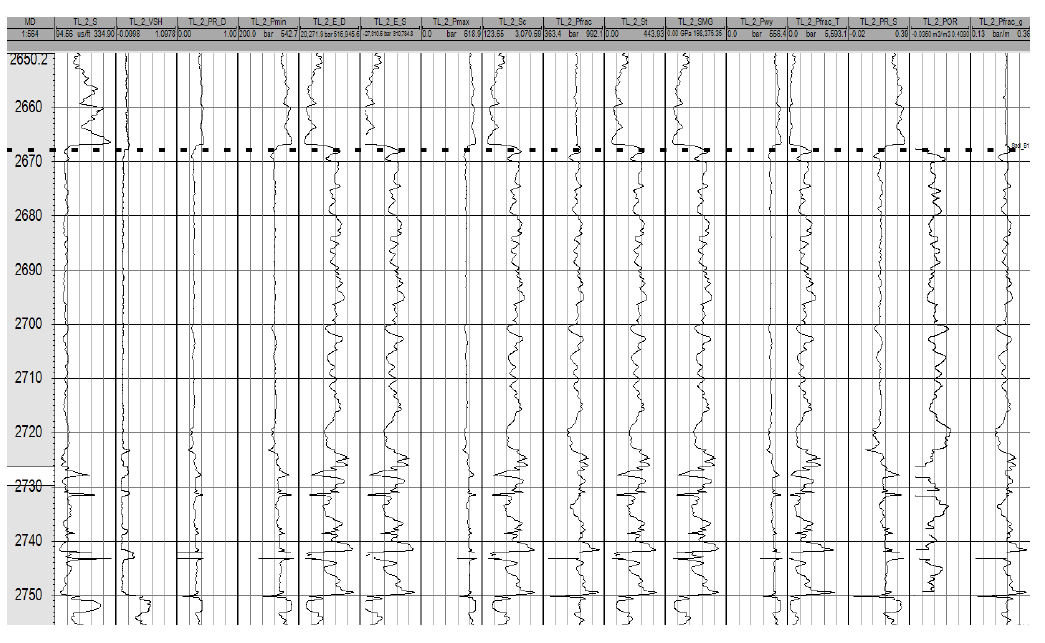
Processes 2022 , 10 , x FOR PEER REVIEW Figure 5. Curves of rock mechanics parameters. Figure 5. Curves of rock mechanics parameters.